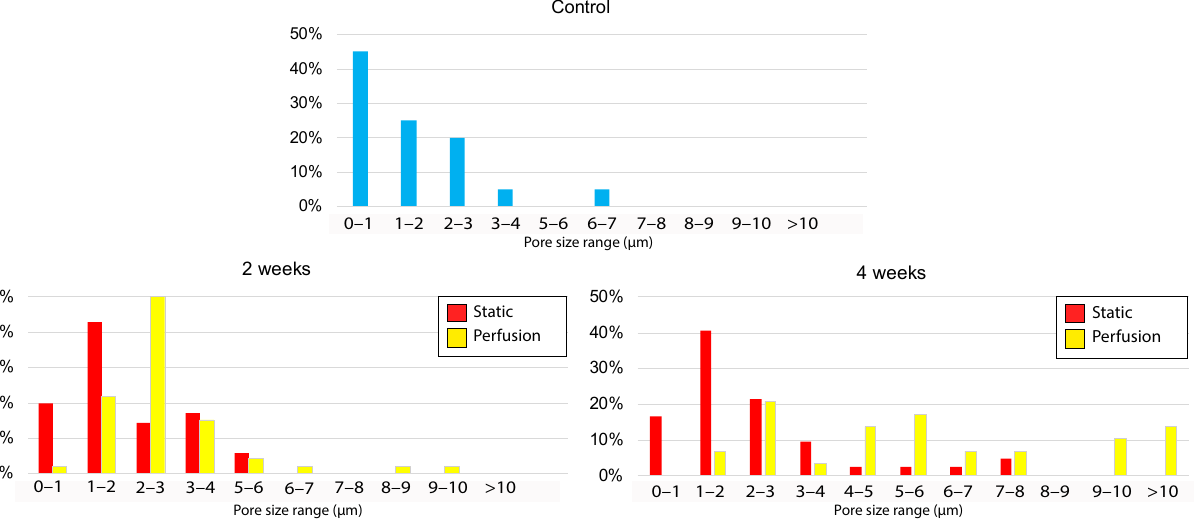
Figure 5. Surface pore size distribution. Percentage of pore size occurrence in the different samples: control (blue), static (red) and perfusion (yellow). At least 30 pores were measured for each condition to determine size